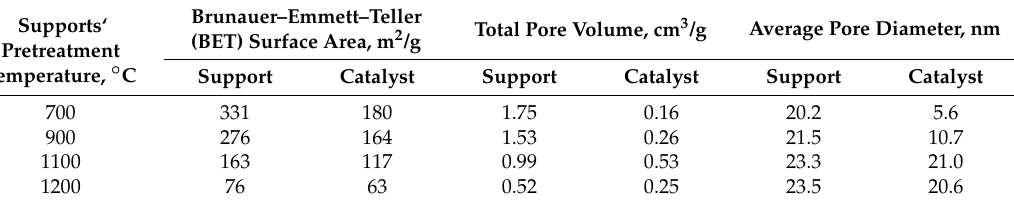
Table 1. Surface area, pore volume and pore diameter of supports and catalysts after pretreatment for 2 h at four different temperatures.